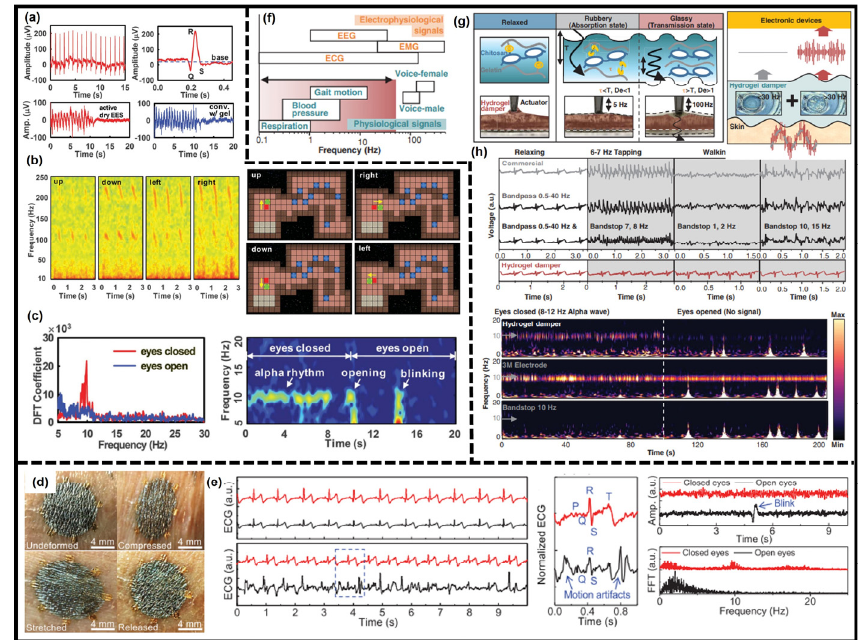
Figure 8. The wearable systems used in electrophysiological signals monitoring. ( a ) ECG ( top ) signals measured with a wearable EES and obtained EMG ( bottom ) signals compared with conventional sensors. ( b ) Spectrogram of the EMG data mounted on the neck during vocalization of four different words ( left ) and simulated video game control by EMG data. ( c ) EEG alpha rhythms measured by EES. Reproduced with permission from ref. [23]. Copyright 2011 American Association for the Advancement of Science. ( d ) Skin − gate van der Waals transistor on human skin under different deformation. ( e ) The ECG signals measured by the skin − gate transistor (rad line) and Ag/AgCl electrode (black line) ( left ) and recorded EEG signals (closed eyes and open eyes) ( right ). Reproduced with permission from ref. [227] . Copyright 2022 American Association for the Advancement of Sci- ence. ( f ) Representative frequency ranges of human mechanical and electrophysiological biosignals. ( g ) Schematic illustration of selective biophysiological signal detection through the hydrogel damper and the selective damping mechanism. ( h ) The ECG and EEG signals measured with the hydrogel damper. Reproduced with permission from ref. [228] . Copyright 2022 American Associa- tion for the Advancement of Science. To ensure the conformal contact between wearable systems and skin, Yan et al. re- ported the design of a wearable system based on van der Waals thin films (Figure 8d) [227]. The stretchability, malleability, and breathability are ensured simultaneously be- cause the staggered nanosheets can freely slide and rotate under deformations. Moreover, the stretchability of thin films allows the necessary deformation of the sensing layer to adapt to the local surface topography. A conformal contact between thin sensing film and skin is shown in Figure 8d, and there is still no separation, even under compressing and stretching. The excellent contact condition guarantees stable interface impedance, and the applied FET can exactly monitor electrophysiological signals. After attaching this weara- ble FET system to the human skin, the ECG and EEG signals (i.e., alpha rhythms) are monitored and recorded in real-time (Figure 8e). The ECG signals measured by wearable systems show better anti-interference to mechanical motion compared with traditional Ag/AgCl-monitoring devices. The electrophysiological signals are seriously disturbed by the unexpected move- ments of patients. As for the human body, mechanical motions are perennial and super- imposed on electrophysiological signals [229]. The current methods to avoid disturbing movements rely on signal processes such as bandpass filters, which may result in signal loss [230]. Park et al. were inspired by the viscoelastic cuticular pad in nature (e.g., spider) and presented a wearable electrophysiological signal-monitoring system based on a band- pass filter material [228]. The unexcepted movements are in a low-frequency range, such